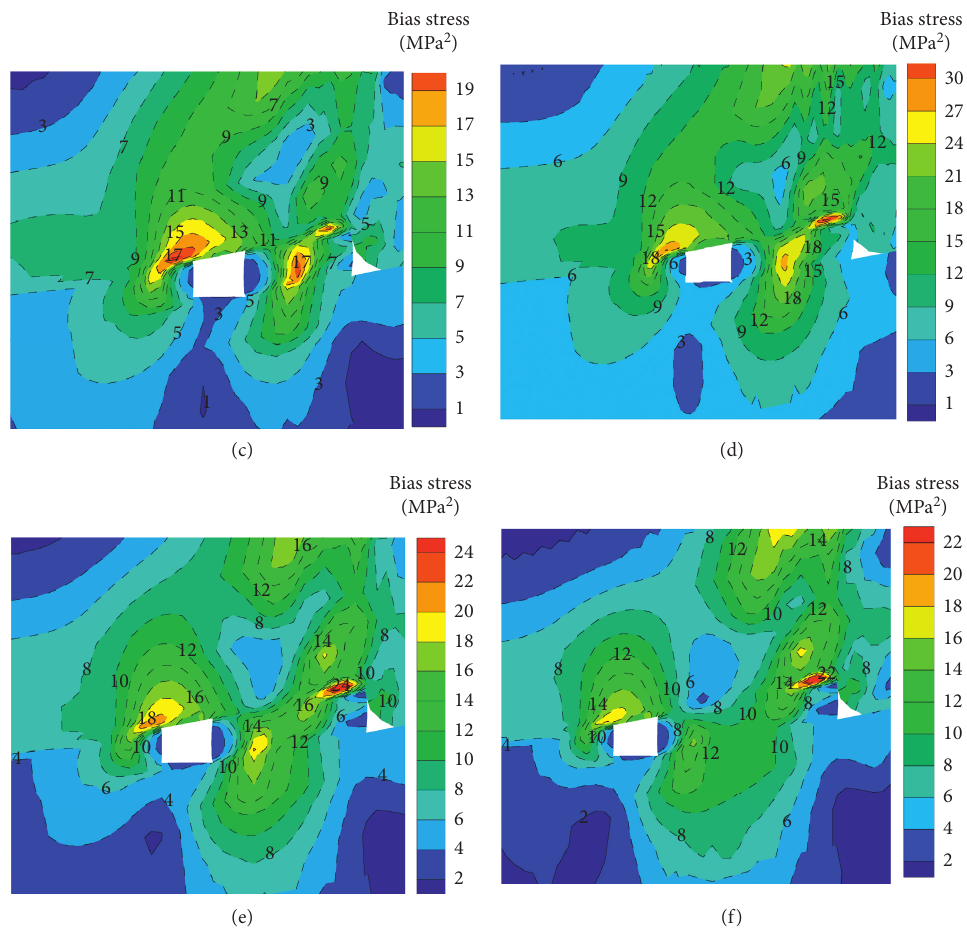
Figure 5: The second invariant of deviatoric stress cloud in the surrounding rock of the roadway under different width coal pillars. (a) 5m coal pillar, (b) 8 m coal pillar, (c) 10m coal pillar, (d) 12.5m coal pillar, (e) 15m coal pillar, and (f) 20m coal pillar.